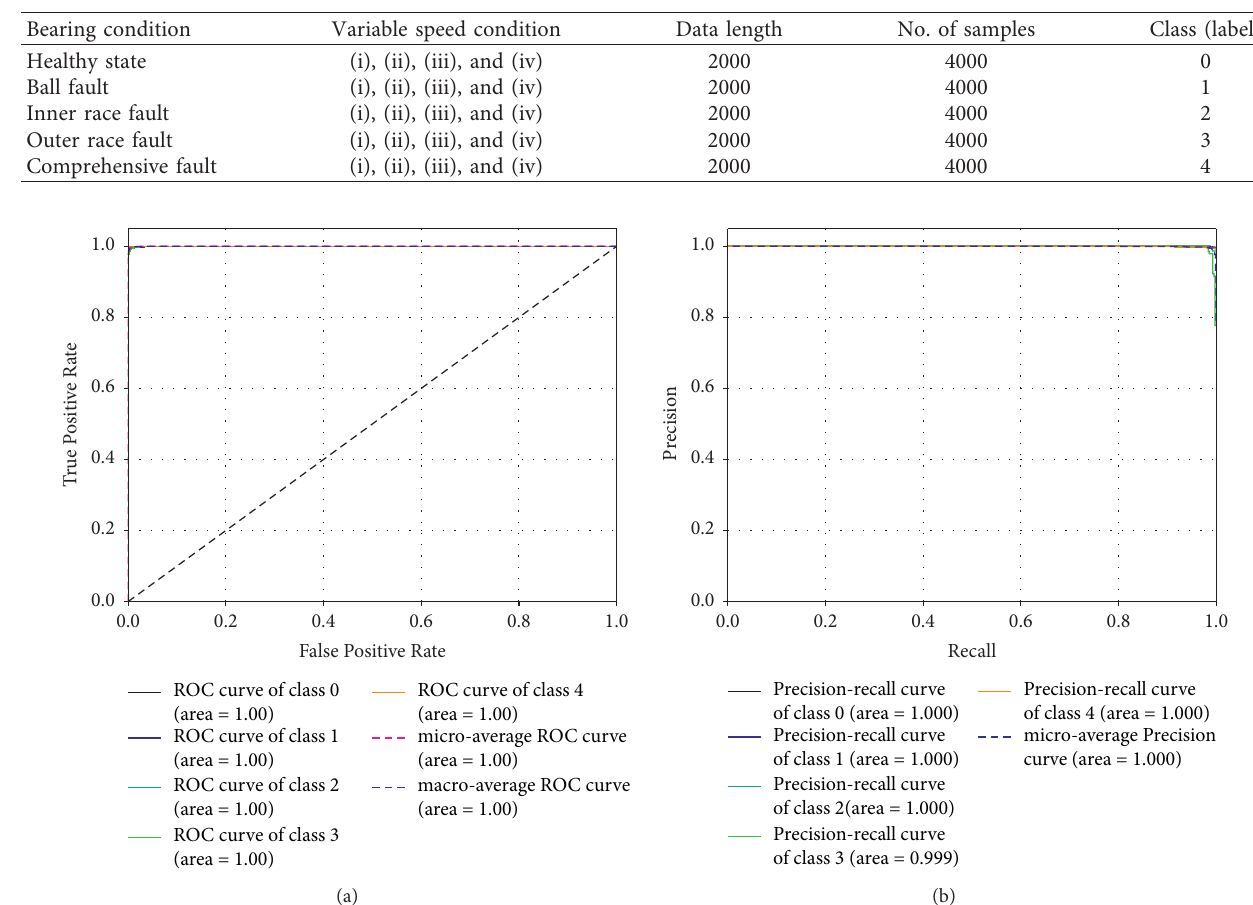
Table 6: uOttawa experimental sample.